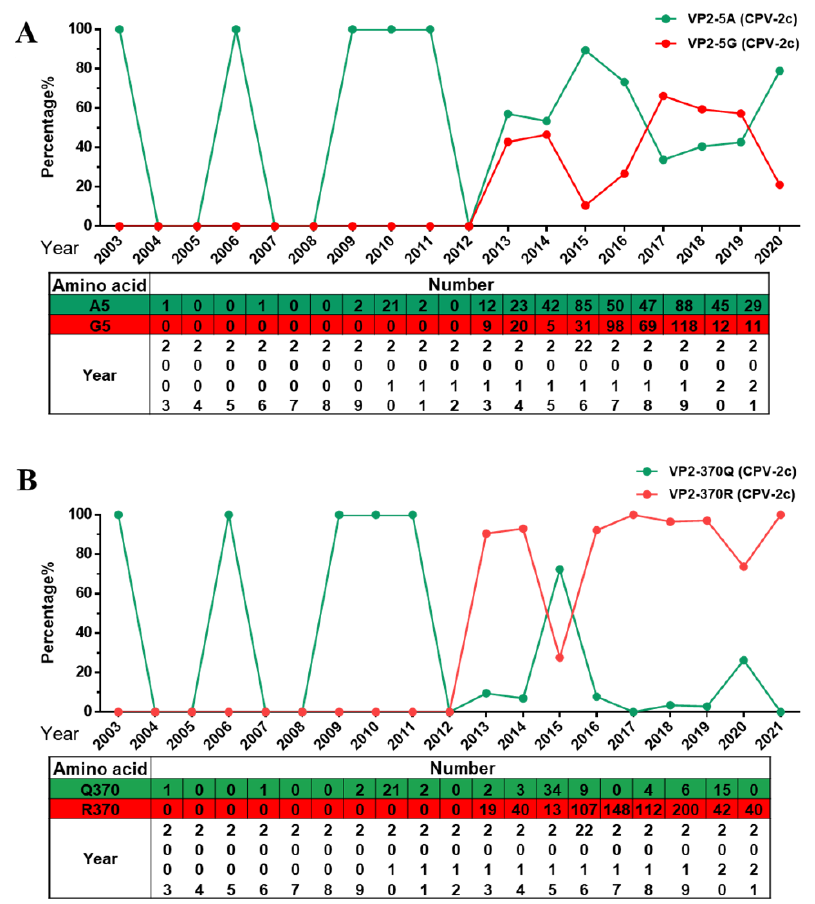
Figure 6. Analysis of amino acid mutations at specific sites in the Asian CPV-2c VP2 gene. ( A ) Per- centage and number of amino acids at site 5 of VP2. ( B ) Percentage and number of amino acids at site 370 of VP2.